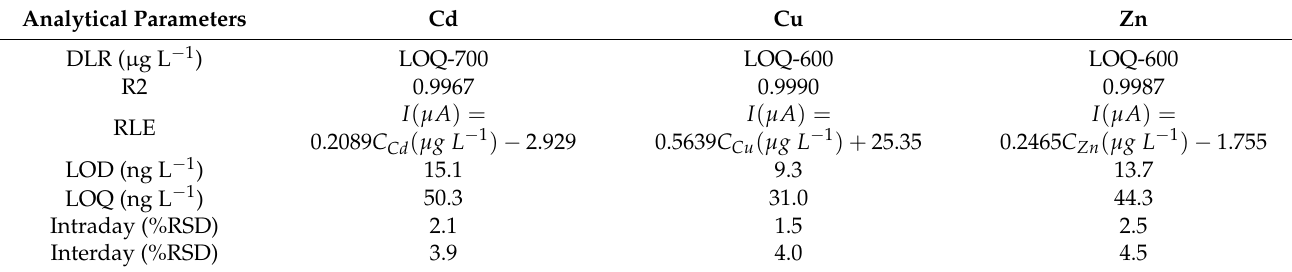
Table 2. Analytical parameter of the MnO 2 @RGO/GCE for the determination of Cd, Cu, and Zn ions.